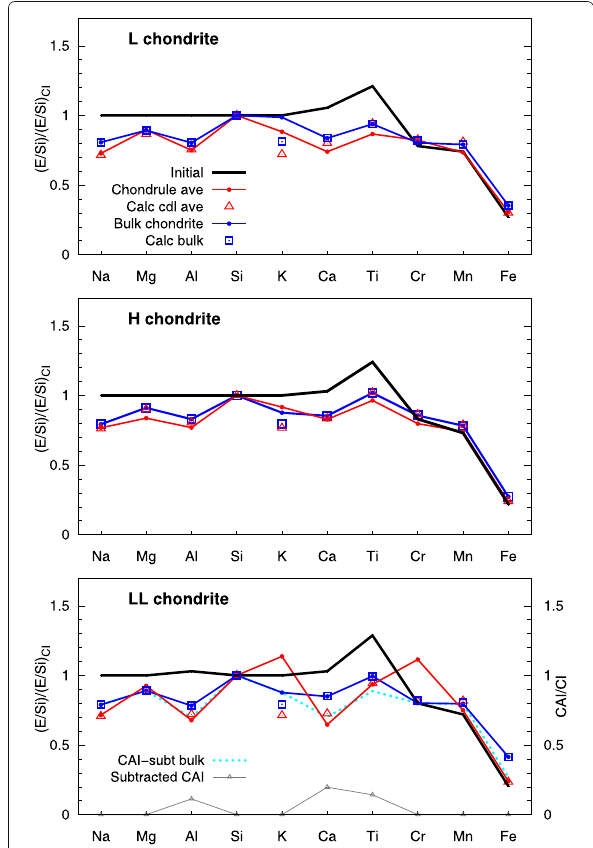
Fig. 3 Results of numerical fittings for L, H and LL chondrites, that incorporate the effect of CAIs and ghost CAIs. See the captions of Figs. 1 and 2 for notations